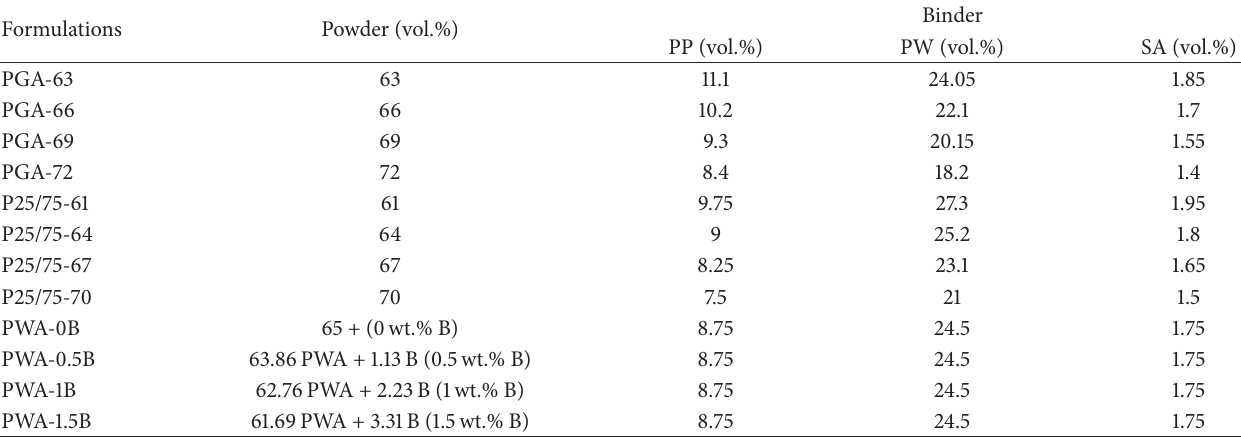
Table 1: Components used for preparation of various feedstocks.